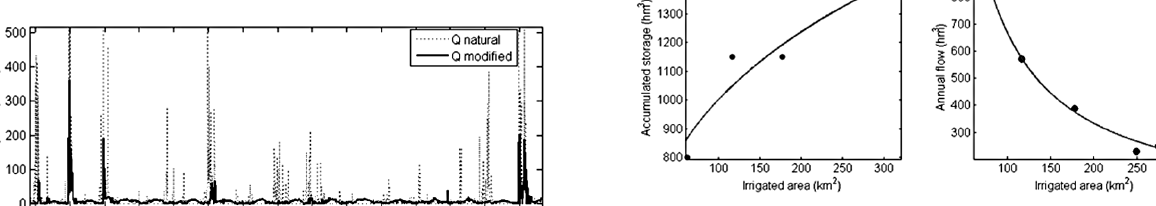
Figure 5. (a) Relation between storage capacity in the basin con- tributing to Guadalete estuary and irrigated crops area and (b) rela- tion between annual flow discharged to the Guadalete estuary in the last 20years and irrigated crops area for the period